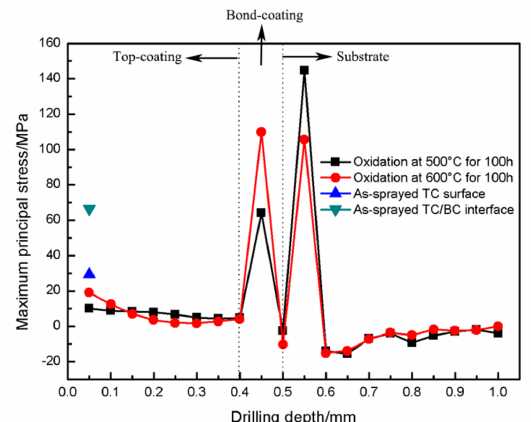
Figure 11. Residual stress distribution along the thickness direction of as-oxidized CuAl seal